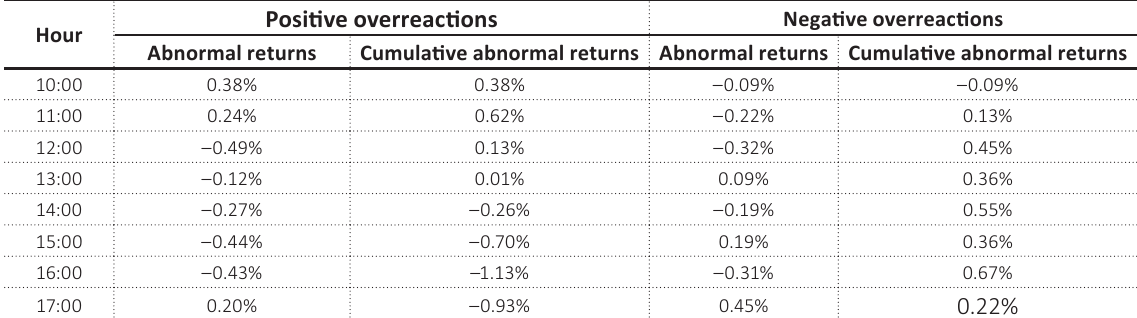
Table 7. Cumulative abnormal returns: case of positive and negative overreactions, UX-C Hour